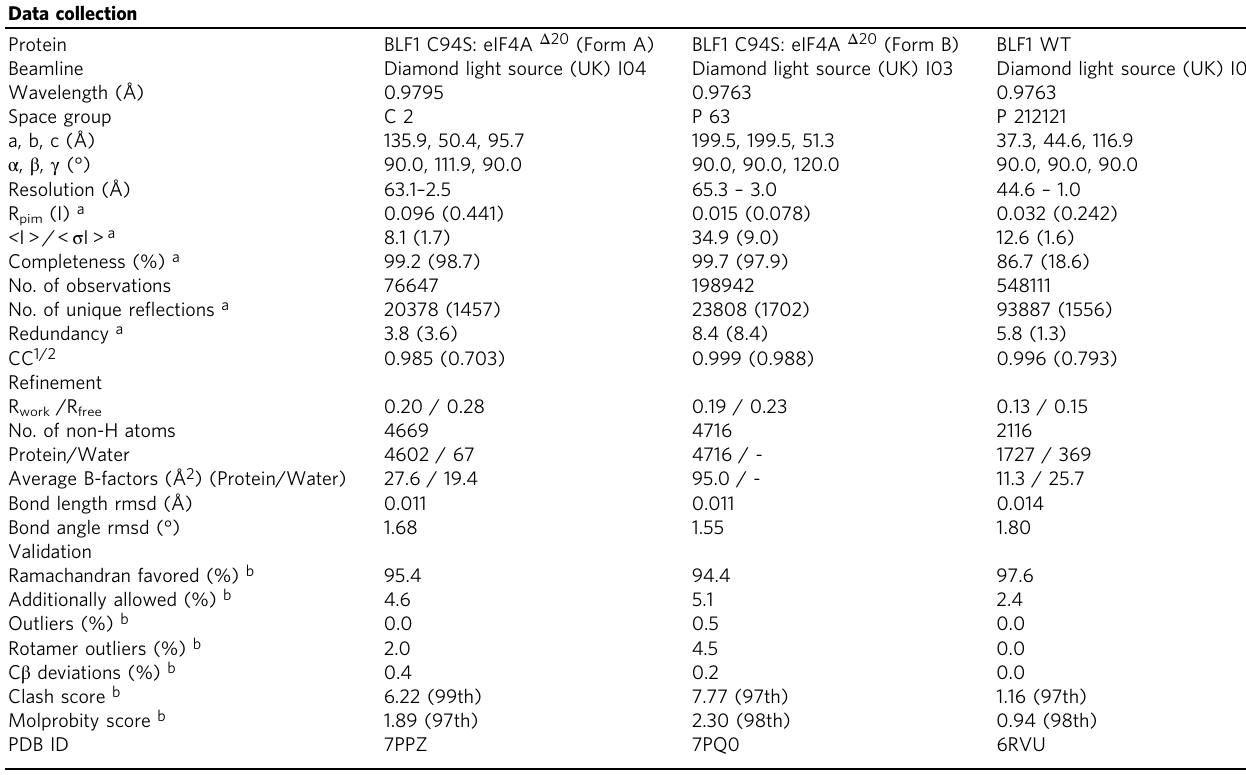
Table 1 Data collection and re fi nement